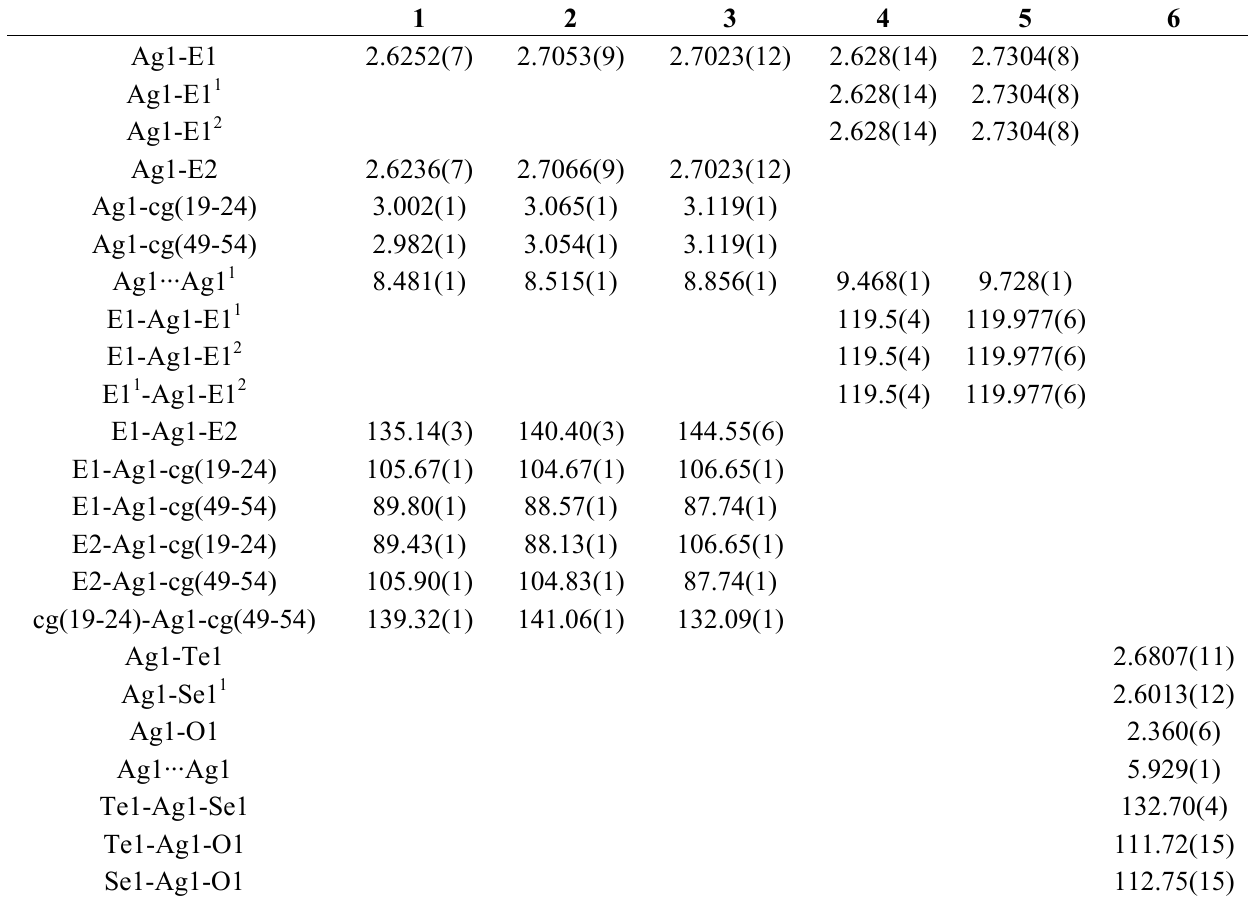
Table 3. Selected silver coordination interatomic distances [Å] and angles [°] for 1 – 6 .